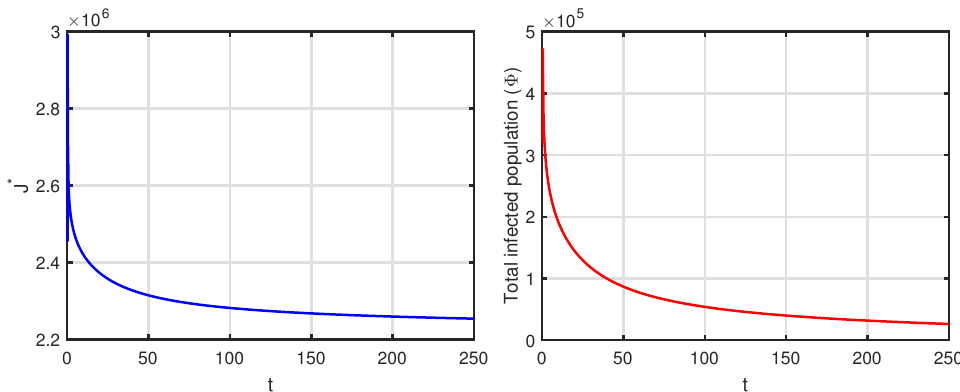
Figure 12. Time series of optimal control variables when combined control strategy is implemented T f = 250, ε = 0.7.